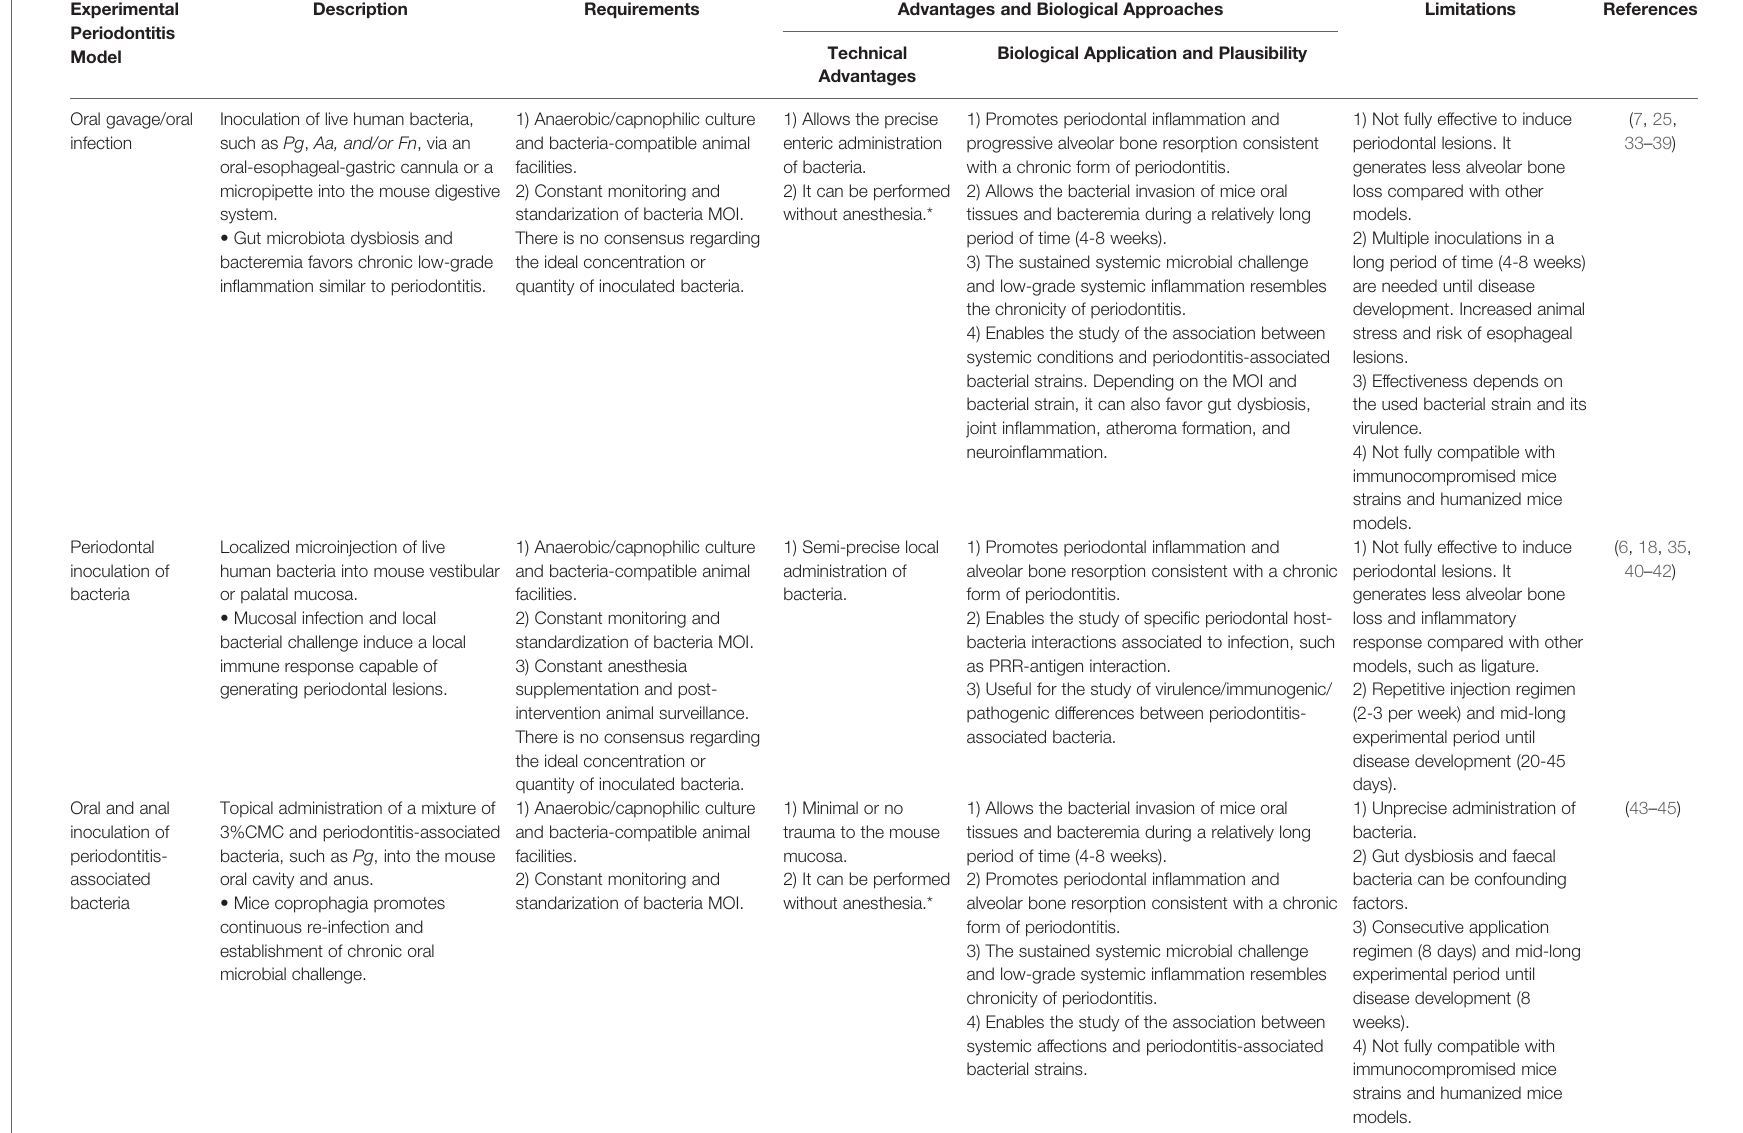
TABLE 1 | The most widely used models to generate experimental periodontitis in